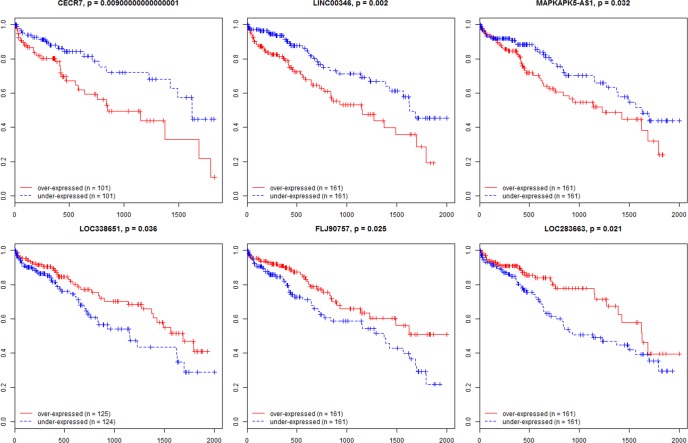
Kaplan-Meier survival curves for six lncRNAs associated with overall survival.(Horizontal axis: overall survival time: days, Vertical axis: survival function).